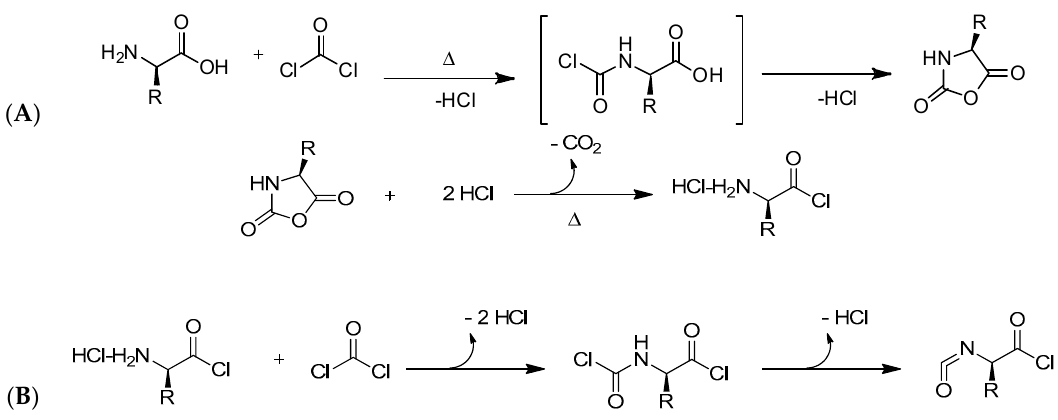
Figure 2. The mechanism proposed for the “Fuchs-Farthing” method [22–24]. ( A ) N -carboxyanhydrides (NCAs) formation by reaction with phosgene and ( B ) Formation of NCA and acidic decomposition.